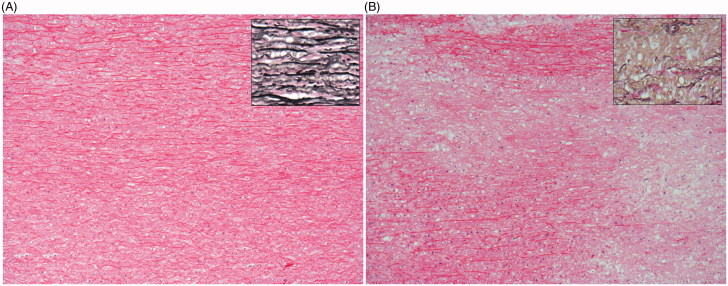
Histological appearance of aortic wall in samples from bicuspid valve (A) and amyloid-rich (B) groups. Appearance of aorta exhibiting a structure within normal limits and correct orientation of elastic fibres (inset) (A). Loss of structure, and de-arrangement of smooth muscle and elastic fibres (inset) (B). Haematoxylin Eosin, original magnification ×100; Inset: Verhoeff-van Gieson (EVG), original magnification ×400.